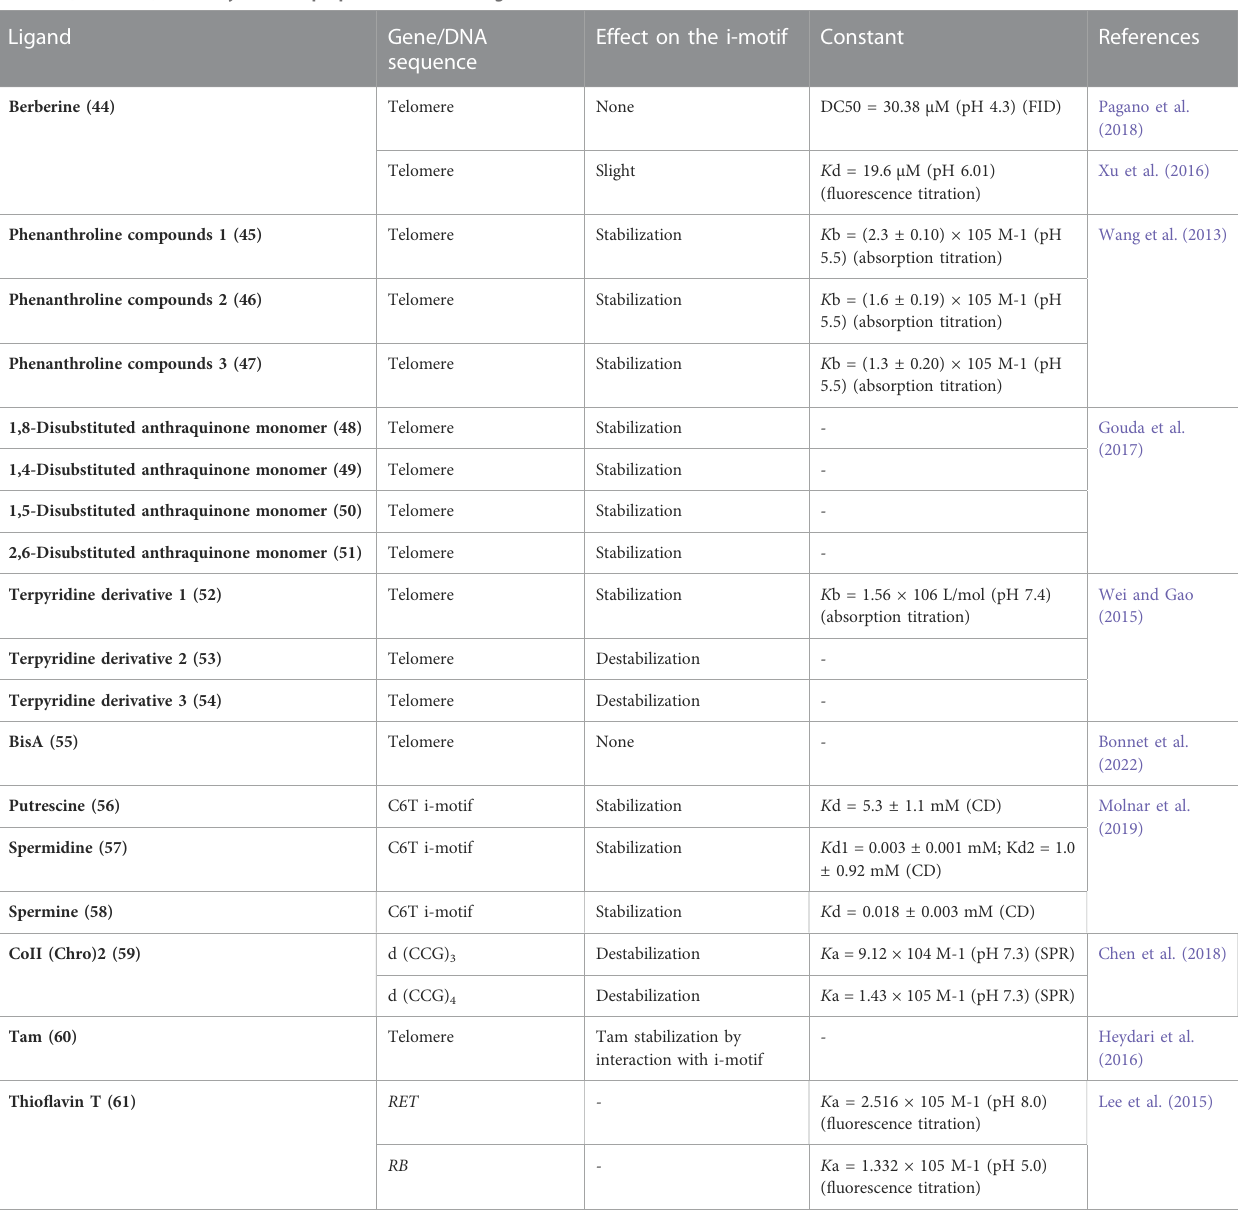
TABLE 1 ( Continued ) Summary of some properties of i-motifs